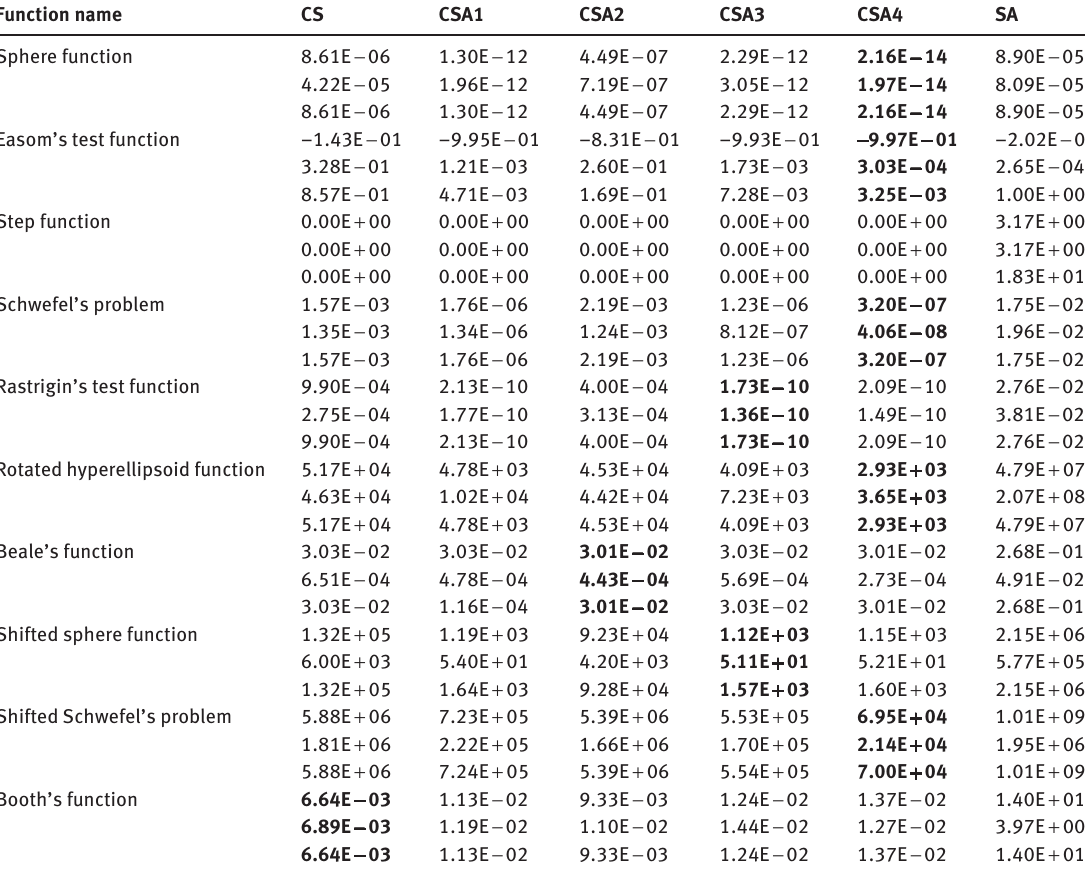
Table 4: Experimental Results of the Algorithms for each of the 10 Benchmark Functions. Function